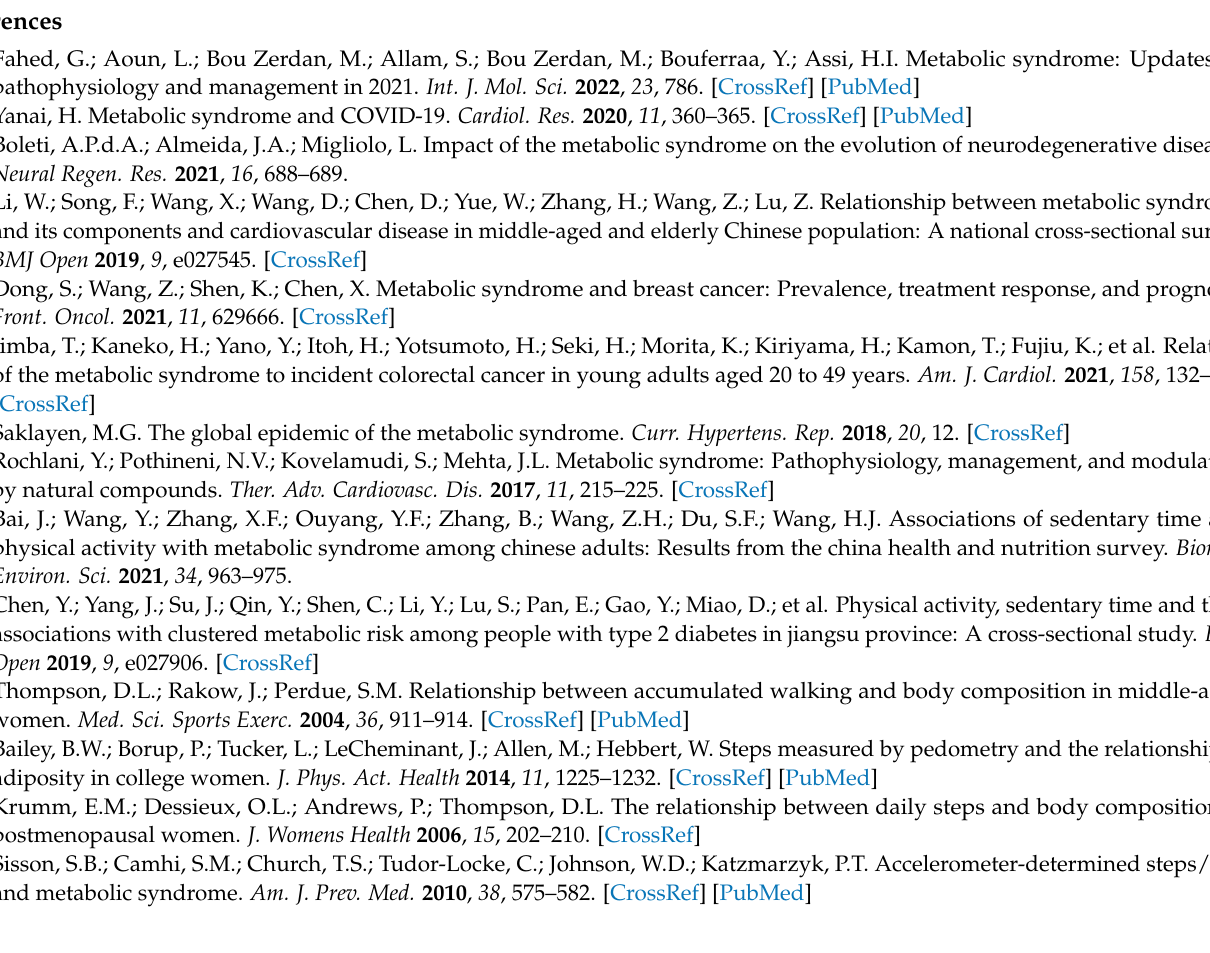
Figure A1. Receiver operating characteristic curves of daily step count required for improvement in the number of metabolic syndrome components in participants ( a ) with metabolic syndrome and ( b ) without metabolic syndrome. The daily step counts required to maximize the Youden Index in participants with and without metabolic syndrome were 11,438 (sensitivity 69.2%, specificity 70.6%) and 12,382 (sensitivity 61.5%, specificity 65.5%),